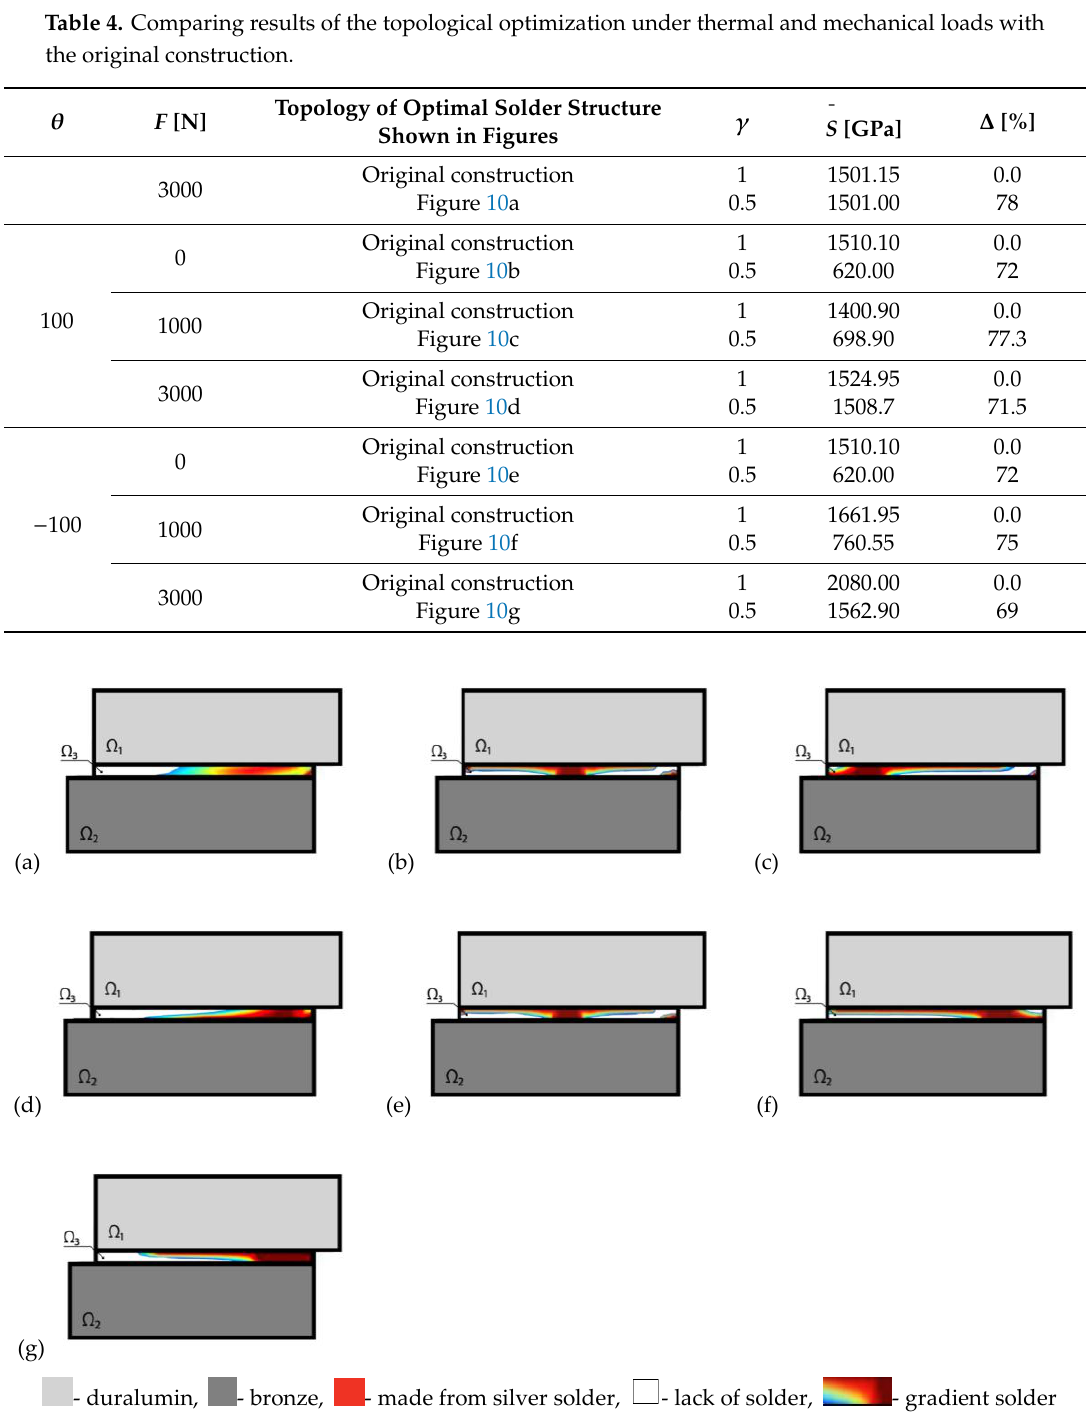
Figure 10. Topology of the optimal solder construction under thermal and mechanical loads. ( a ) θ = 0 °C, F = 3000 N; ( b ) θ = 100 °C, F = 0 N; ( c ) θ = 100 °C, F = 1000 N; ( d ) θ = 100 °C, F = 3000 N; ( e ) θ = −100 °C, F